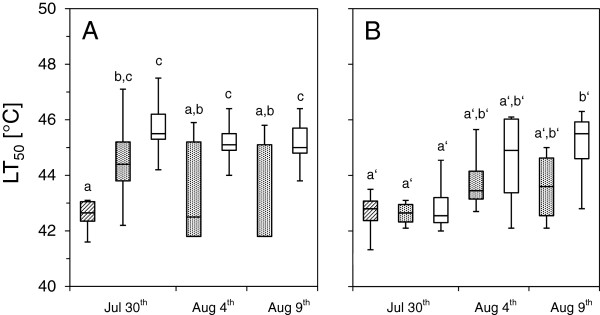
Leaf heat tolerance of R. ferrugineum. Measurements were performed on Mt. Patscherkofel (1960 m a.s.l.) using different methodical approaches with regard to the controlled heat exposure. Measurements took place on 27 July 2012 and the following assessment procedures were used: 1. Heat exposure of detached leaves (ex situ, in darkness), 2. In situ heat exposure using the Heat Tolerance Testing System (in darkness and under natural solar irradiation). A. Viability assessed by the visual estimation method (VEM). LT50 of excised leaves (hatched box) and LT50 determined in situ and in darkness (sprinkled box) did not differ significantly (exception: 30 July 2012). LT50 determined in situ under natural solar irradiation (white boxes) was always significantly higher. B. LT50 assessed by the chlorophyll fluorescence method (CHFL) showed no significant differences when detached leaves (hatched box) or attached leaves in situ in darkness (speckled box) were compared. LT50 determined in situ under natural solar irradiation (white boxes) was also not different except for 9 Aug 2012. Boxes: median, upper and lower quartile. Whiskers: maximum, minimum. Significant differences between mean values of heat tolerance based on ANOVA and the Duncan - test are indicated by different letters (P < 0.05).